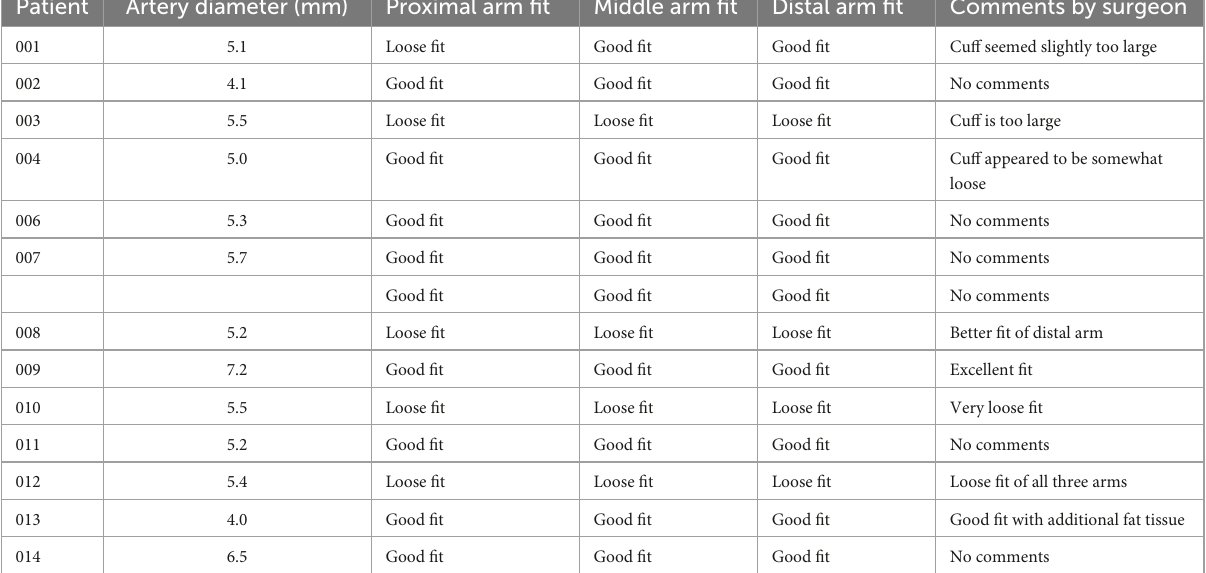
TABLE 2 Artery diameter and cuff